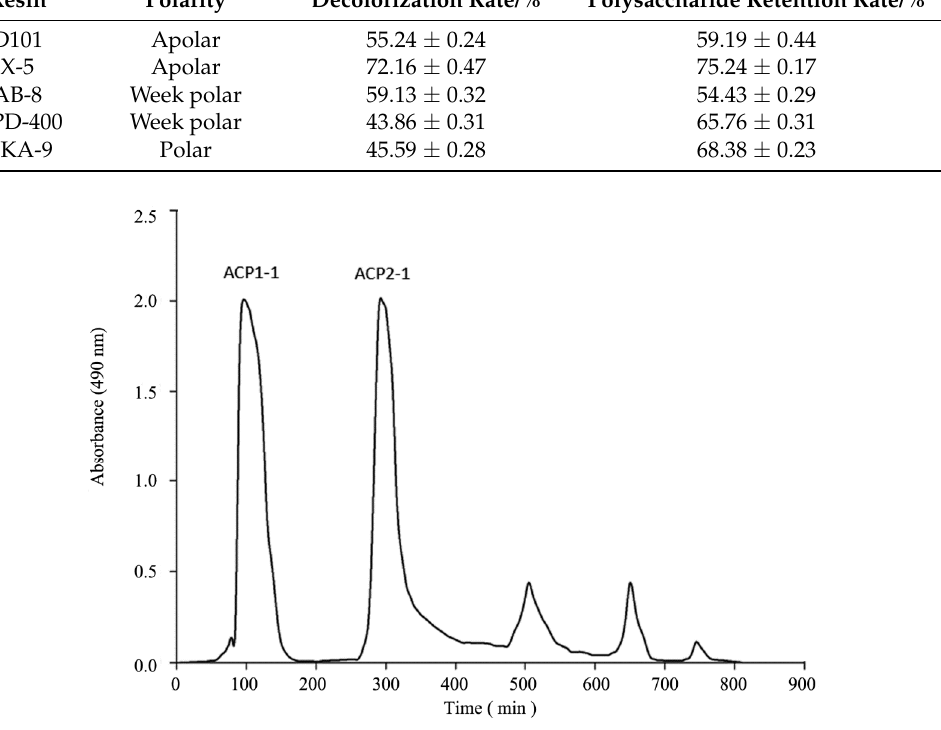
Figure 1. Elution profiles of crude polysaccharide ACP on a DEAE-52 column.